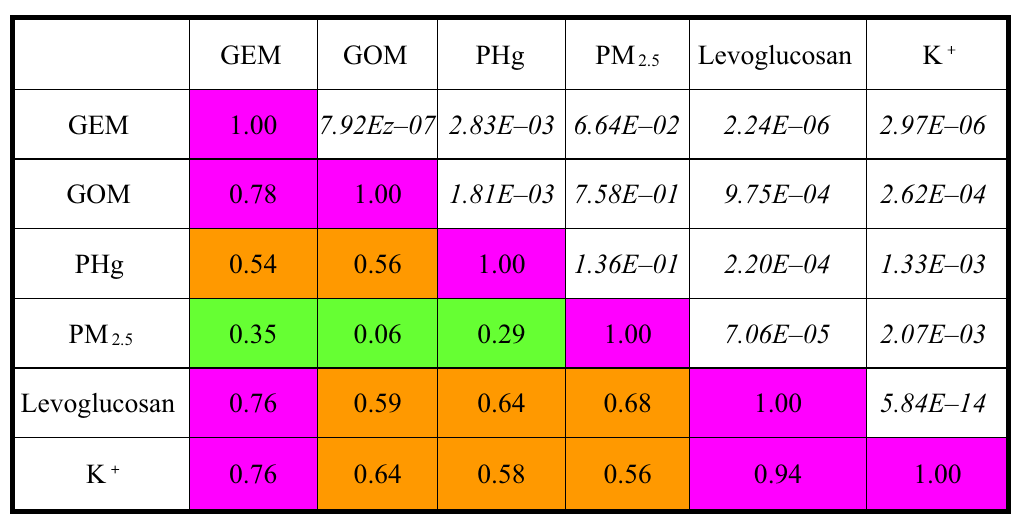
Table 3. Correlation coefficients and p values of atmospheric speciated mercury, PM 2.5 , Levoglucosan, and K + . GEM gaseous elemental mercury, GOM gaseous oxidized mercury, PHg particle-bound mercury, RH relative humidity, WS wind speed; Color Index of Correlation Coefficient (r): strong (purple, 0.70–1.00), moderate (brown, 0.40–0.69), and low (green, 0–0.39); Italic Numbers: p